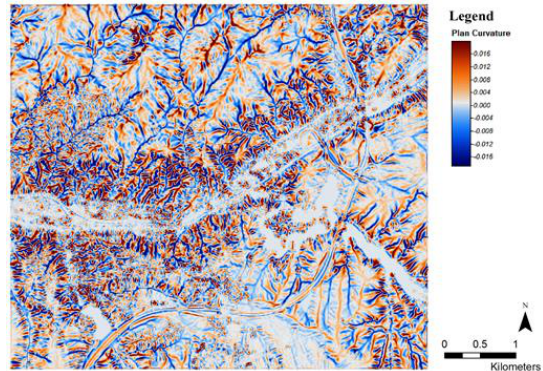
Figure 7. Plan curvature map of the study area.